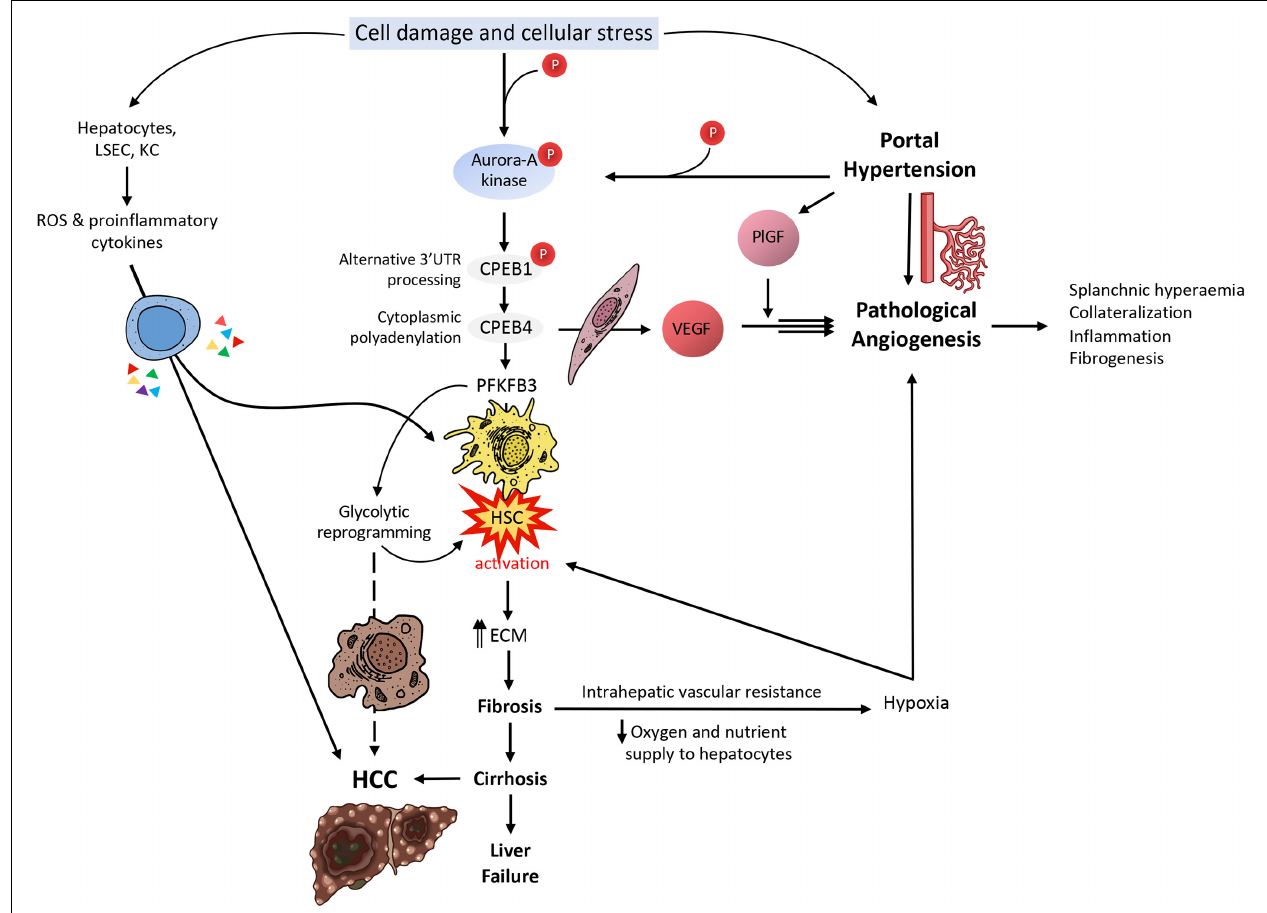
FIGURE 2 | CPEB-mediated translational control in liver disease. Upon cell damage and cellular stress in the liver, Aurora-A kinase is phosphorylated; Aurora-A will in turn phosphorylate CPEB1, which will process mRNAs in their alternative 3 (cid:48) UTR during a first wave of translational activation. One of these mRNAs is CPEB4 mRNA; in a second wave of translational activation, CPEB4 will enhance the polyadenylation of several mRNAs, such as VEGF and PFKFB3, besides its own mRNA. VEGF will cause pathological angiogenesis and its effect will be greatly boosted by PlGF, leading to splanchnic hyperemia, collateralization of blood vessels, inflammation and fibrogenesis. These will cause an increase in portal hypertension, which will increase PlGF levels and increase Aurora-A kinase phosphorylation, both feeding back the VEGF loop. PFKFB3, on the other side, will cause the activation of HSCs, which will start synthesizing ECM elements that will contribute to liver fibrosis and later cirrhosis, if unresolved. Liver fibrosis will cause intrahepatic vascular resistance and thus a reduction in oxygen and nutrient supply to hepatocytes, causing them to enter a hypoxic state; upon this situation, hepatocytes will produce angiogenic factors, attempting to resolve the situation, but actually making it worse. On the other hand, cirrhosis is well-known for being the most common prelude for HCC. The glycolytic switch caused by the overexpression of PFKFB3 in this specific context might likely facilitate the survival of transformed cells in a hypoxic millieu. Hepatocytes, LSECs and KCs will also respond to cell damage and cellular stress by producing ROS and liberating proinflammatory cytokines, contributing to the activation of HSCs and the progression of